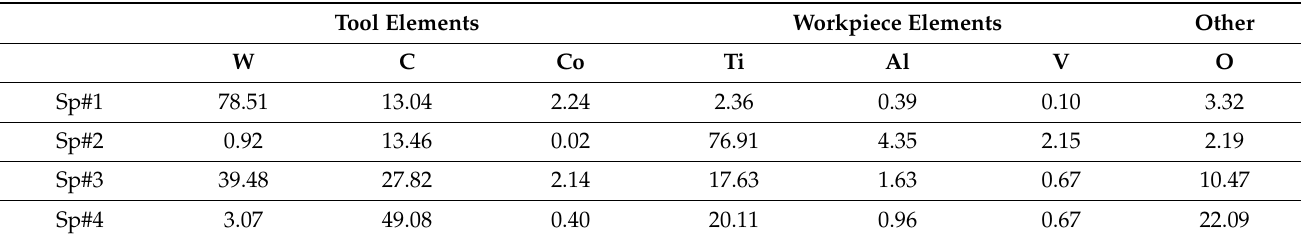
Table 6. EDS Spectral analysis of locations identified in Figure 17d.